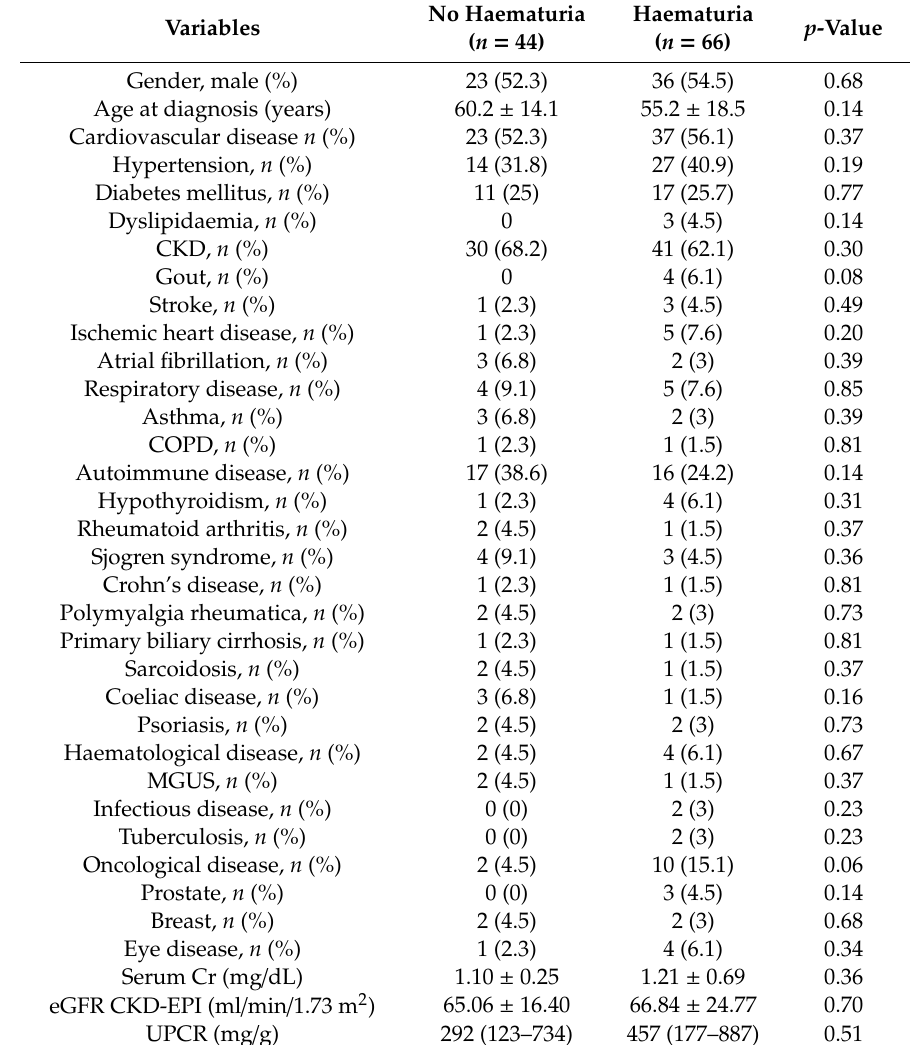
Table 1. Baseline patient characteristics.